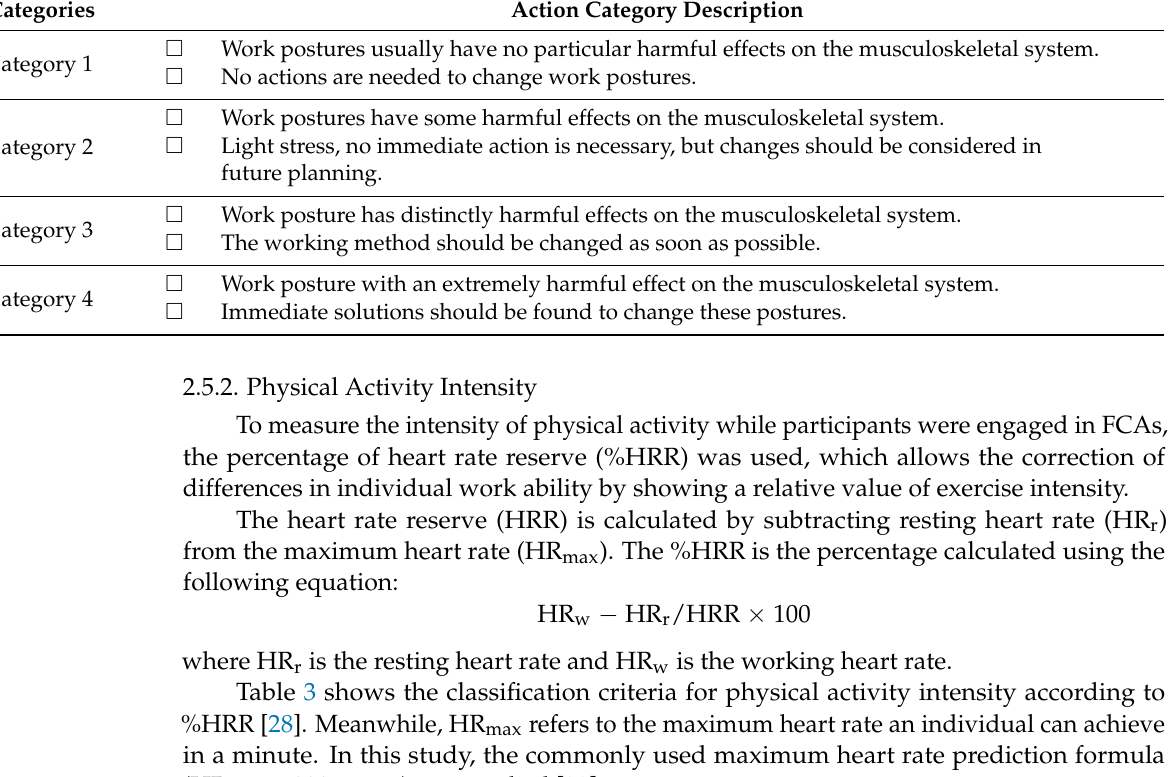
Table 2. OWAS action categories for evaluation of working postures. OWAS Categories Action Category Description